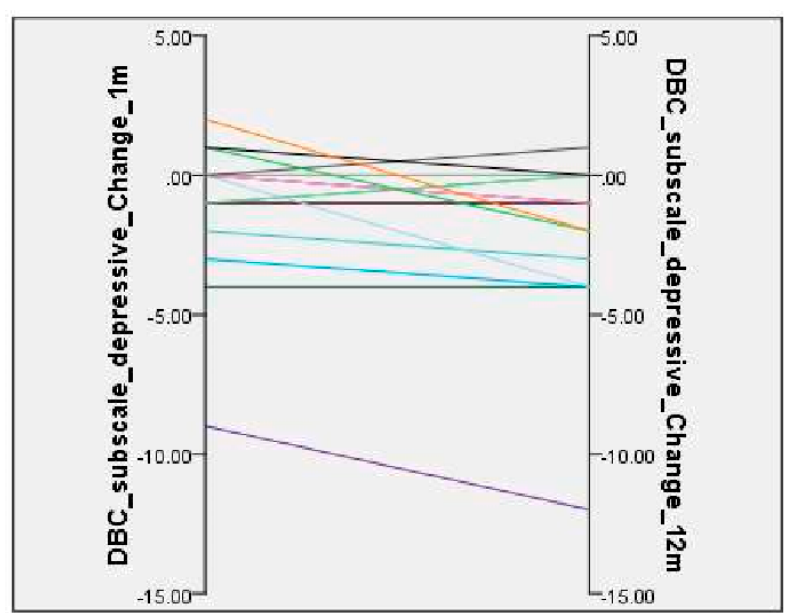
Figure A4. Scores on the Developmental Behaviour Checklist for Adults (DBC-A) subscales at baseline and at 12 months: Anxiety/Antisocial Scale.